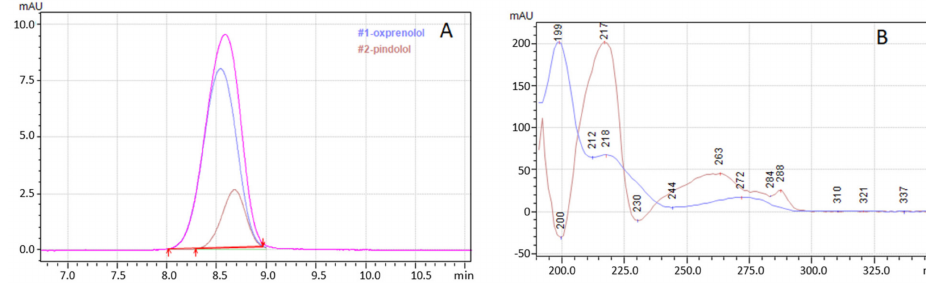
Figure 6. Deconvolution of unseparated oxprenolol and pindolol on Diol-P-Benzyl column in 90% of ACN ( A ) and corresponding UV spectra ( B ). Pink line represent signal obtained from